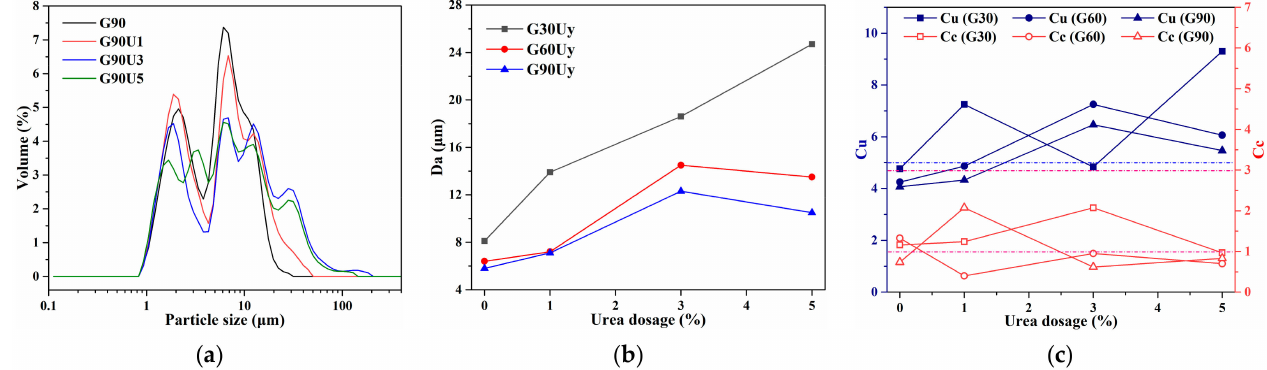
Figure 3. Particle size distribution ( a ), average diameter Da ( b ), Cu and Cc ( c ) of Gx and